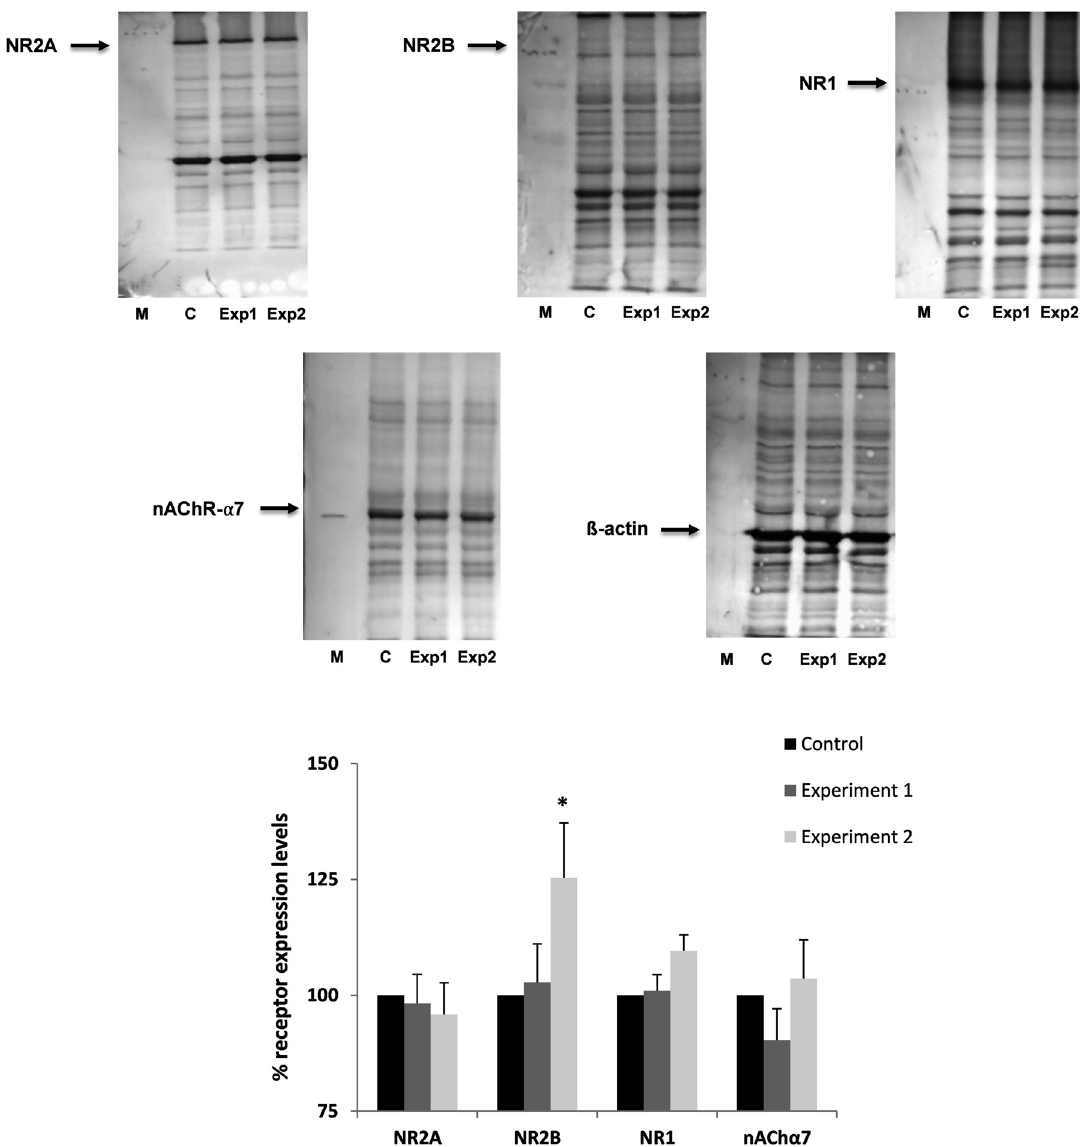
Figure 2: Representative images of Western blot analysis for each receptor and comparison of % expression levels between groups. β -Actin and the receptors on each membrane are denoted with an arrow. *Indicates a signi fi cant di ff erence compared to the CG (p<0.001). M, prestained marker; C, control; CG, control group, Exp 1, experiment 1; Exp 2, experiment 2. Data are given as mean ±